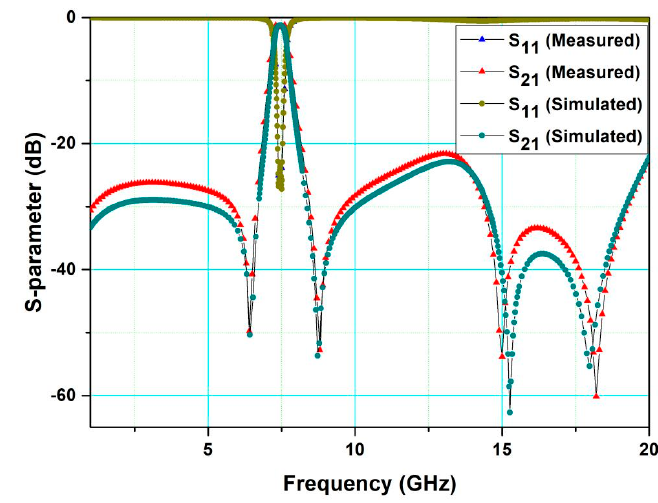
Figure 7. Simulated and measured results of the proposed BPF with stub-loaded folded open-loop resonators. Table 1. Comparisons to other similar fabricated designs.